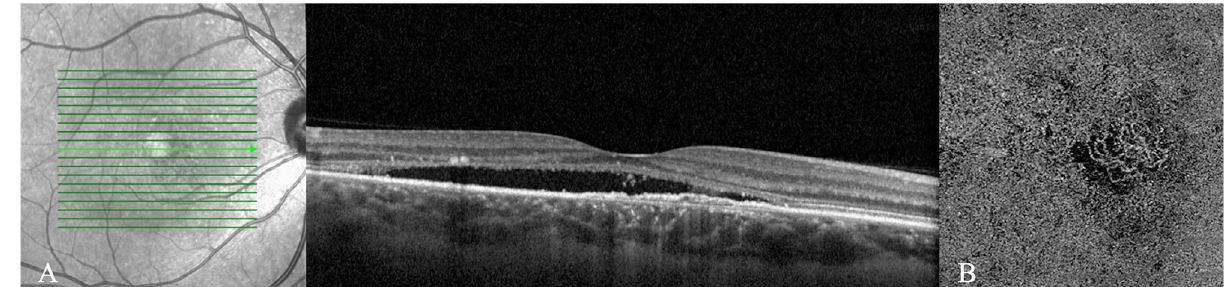
Figure 2. ( A ) Enhanced-depth imaging optical coherence tomography reveals dilated Haller’s layer vessels and attenuation of the choriocapillaris, and a flat irregular pigment epithelium detachment (FIPED) associated with subretinal fluid (SRF) and subretinal hyperreflective foci. ( B ) The enface OCT angiography demonstrates a neovascular lesion with tangled filamentous pattern within the FIPED.